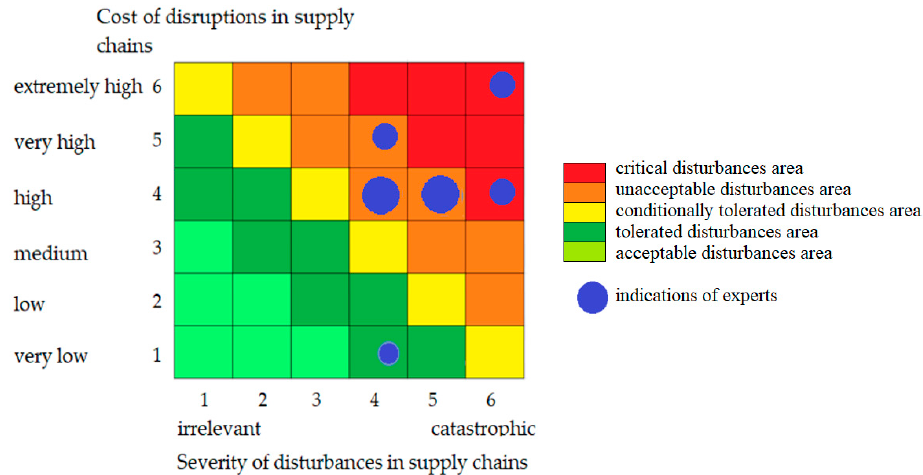
Figure 10. The severity of disruptions and the cost of disruptions in the supply chain.